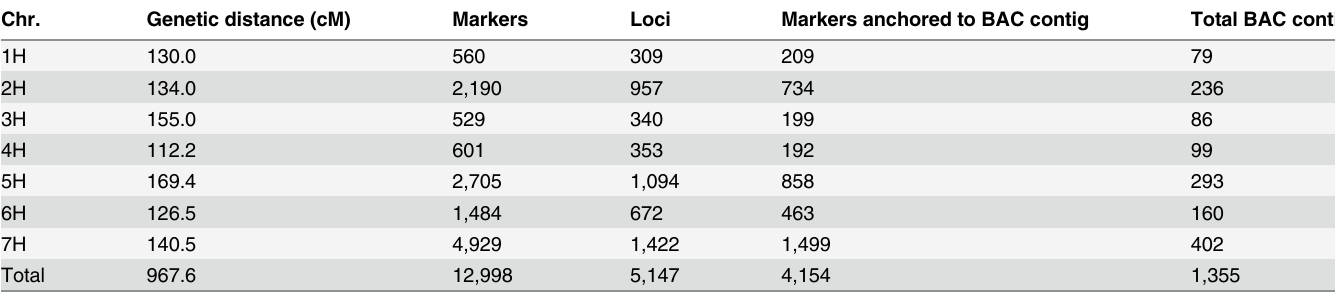
Table 1. SNP markers details across each